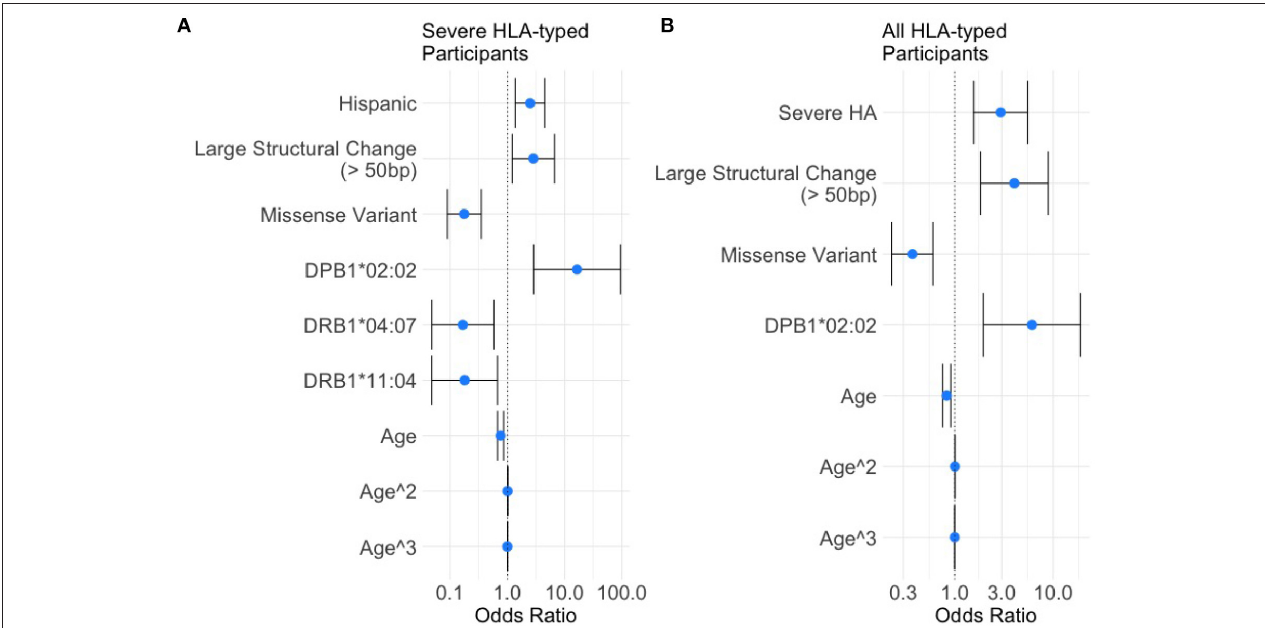
FIGURE 3 | Results of the multivariate analysis. (A) Severe HA participants increased odds of inhibitor development were found for Hispanic participants (OR = 2.50, 95%CI 1.37–4.54), large structural variants (OR = 2.85, 95%CI 1.21–6.67), and HLA-DPB1 * 02:02 (OR = 16.50, 95%CI 2.87–94.78). Decreased odds were found for missense variants (OR = 0.18, 95%CI 0.089–0.35), HLA-DRB1 * 04:07 (OR = 0.17, 95%CI 0.048–0.58), and HLA-DRB1 * 11:04 (OR = 0.18, 95%CI 0.048–0.67). (B) All HLA participants increased odds of inhibitor development were found for severe HA (OR = 2.92, 95%CI 1.56–5.50), Large structural variants (OR = 4.03,